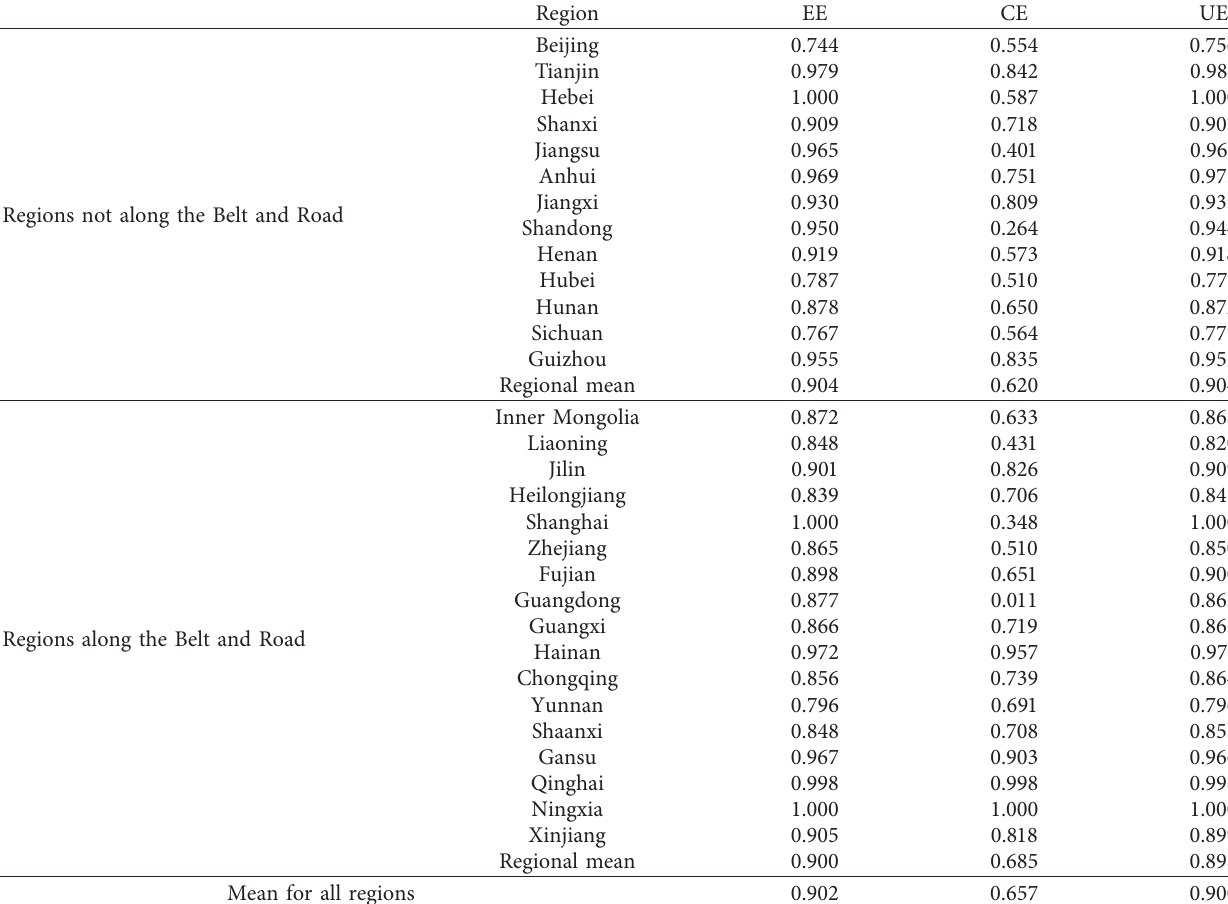
Table 3: Average values of three types of transportation infrastructure efficiency in China, 2007-2018. Region